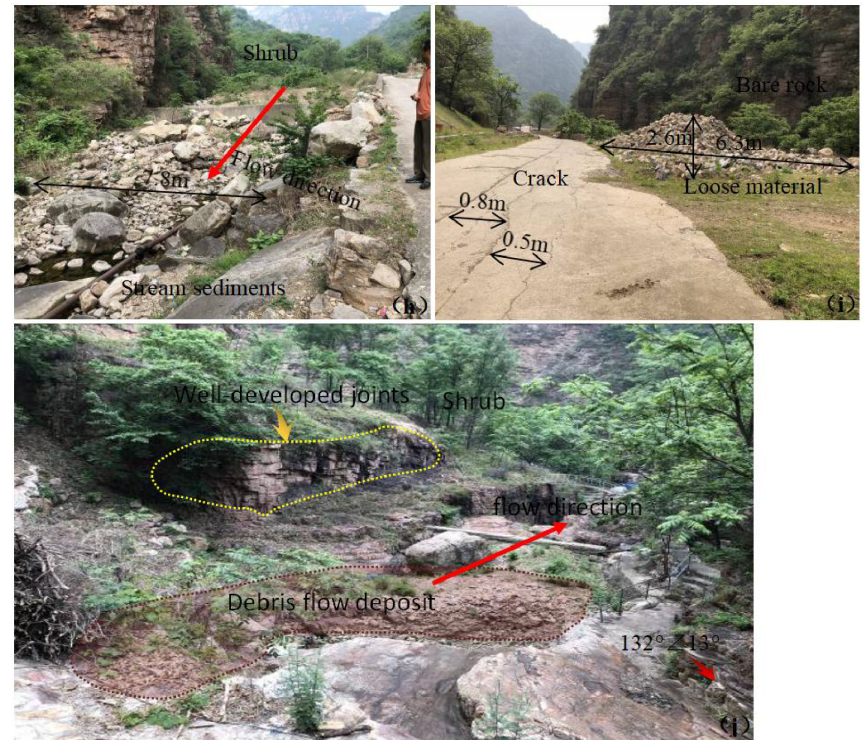
Figure 5. Lishu scenic spot. h is stream sediments, i is road cracks and g is debris flow deposit.